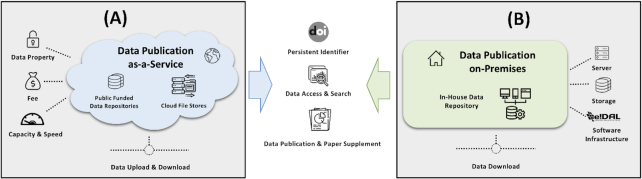
Data-publication-as-a-service vs data-publication-on-premises: both services feature FAIR data publication but differ in costs. The as-a-service model (A) costs a fee, involves delegation of data property control, and faces capacity limits in storage and data upload. The on-premises model (B) keeps data in-house but requires the availability of server and storage hardware as well as the installation of the e!DAL software.